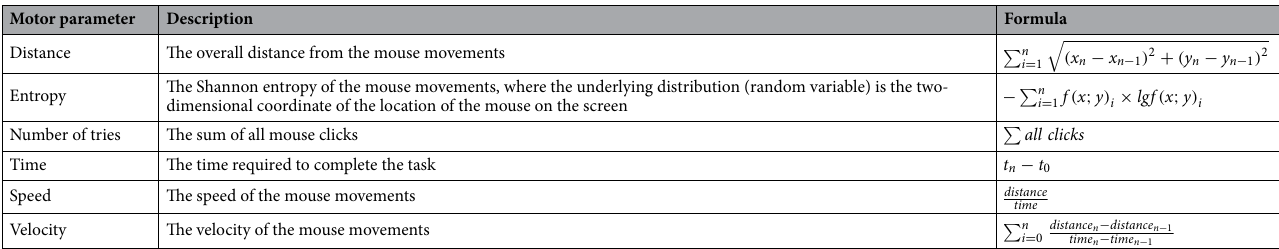
intergroup comparisons represented by nominal p’s, suggesting their value as potential discriminative candi- dates. Results Demographic, clinical, and cognitive characteristics. Eighty individuals (31 MCI and 49 controls) of the databank matched the selection criteria. Twelve (9 MCI patients and 3 healthy individuals) declined the participation. Finally, sixty-eight individuals participated in our research, forty-six of whom belonged to the healthy control (HC) group while twenty-two belonged to the mild cognitive impairment (MCI) group. The HC group contained 27 females (58.70%) while the MCI group included 12 females (54.55%). Significant differ- ences across the groups in the distribution of sex (p = 0.225) or in the length of education (p = 0.128) were not found. The two groups significantly differed in their age (F = 0.638; p = 0.019) and in some neuropsychological features including total ACE score (F = 60.086; p < 0.001), ACE letter fluency (F = 5.07; p = 0.028), ACE category fluency (F = 31.48; p < 0.001), RAVLT sum-5 score (F = 110; p = 0.015), RAVLT 7 score (F = 69.84; p = 0.008) and CDR score (Z = − 4.284; p < 0.001). MCI group also showed lower entorhinal thickness (F = 3.86, p = 0.017) and reduced grey matter volume (F = 4.21, p = 0.012) compared to HC. In other parameters, significant differences were not demonstrated (all p’s > 0.05). Demographic data and cognitive characteristic features are presented in Table 2. Inter‑group comparisons of mouse‑movements. We found significant differences between HC and MCI groups in the distance of left-hand movements (F = 1.16, p = 0.0134), in the time of movements with left hand (F = 4.32; p = 0.005) and in the entropy of the left-hand movements (F = 5.24; p = 0.001) (Fig. 1). The largest difference in the left-hand movements was presented in the entropy (largest F value and large effect size). Simi- lar alterations were presented in the right-hand (dominant hand) movements including the distance (F = 1.03, p = 0.019) required time of movements (F = 4.626; p = 0.003) and entropy (F = 8.46; p < 0.001). The most promi- nent difference was detected in the entropy of right-hand movements (largest F value and large effect size) (Fig. 1). The differences survived the Benjamini–Hochberg correction for time and entropy (corrected p < 0.05), while significance disappeared for the distance (corrected p > 0.05). A non-significant trend was also visible in other motor parameters including more tries, decreased speed, and increased velocity in MCI patients. Exact characteristics are presented in Table 3. Sex, age, and state anxiety level did not have significant modifier effect (all nominal p ’s > 0.05). Based on these estimations, distance, entropy, and duration seemed to be the best candi- dates for further correlation analysis. Interestingly, data of the left hand showed better potential in these param- eters (Fig. 1), represented by the fact that effect sizes were larger than that of the dominant hand (Table 3). Correlation analysis between mouse‑movement parameters and neuropsychological perfor‑ mance. Results of Pearson-correlation analysis between the extracted mouse movement parameters and neuropsychological performance are presented in Table 4 (p-values) and Fig. 2 (r coefficients). Mouse movement parameters showed strong and significant association with the neuropsychological test results including MMSE, ACE, RAVLT, TMT and CDR. However, correlation was not significant between movement parameters, anxiety, and mood measures such as STAI-S, STAI-T, BDI-13. By measures where lower scores indicate worse cognitive status (MMSE, ACE, RAVLT Sum-5, RAVLT 7), negative correlation with the motor parameters were demonstrated in all cases ( r values ranged between − 0.14 and − 0.5). The strongest association was found between movement features and ACE total score (average r: − 0.37, all p’s < 0.05). Time with left hand movements seemed to be the best predictor of cognitive measures in this test series (average r: − 0.38, all p’s < 0.05) (Fig. 3), while entropy was the second best predictor considering r values (average − 0.34 for left hand and − 0.31 for right). The two hands did not differ significantly in the r values (average r for left hand is − 0.29 vs average r for right hand is − 0.29). In the analysis of neuropsychological test results where lower scores indicate better cognitive performance (TMT-A, TMT-B, CDR), positive correlation was detected in all cases with the movement parameters (r values ranged between + 0.1 and + 0.65). The strongest association was present between movement features and the CDR score (average r: − 0.36, all p’s < 0.001). Time with left hand movements seemed to be the best predictor of cognitive skills in this test series (average r: + 0.62, all p’s < 0.001) (Fig. 3), while entropy was also prominent